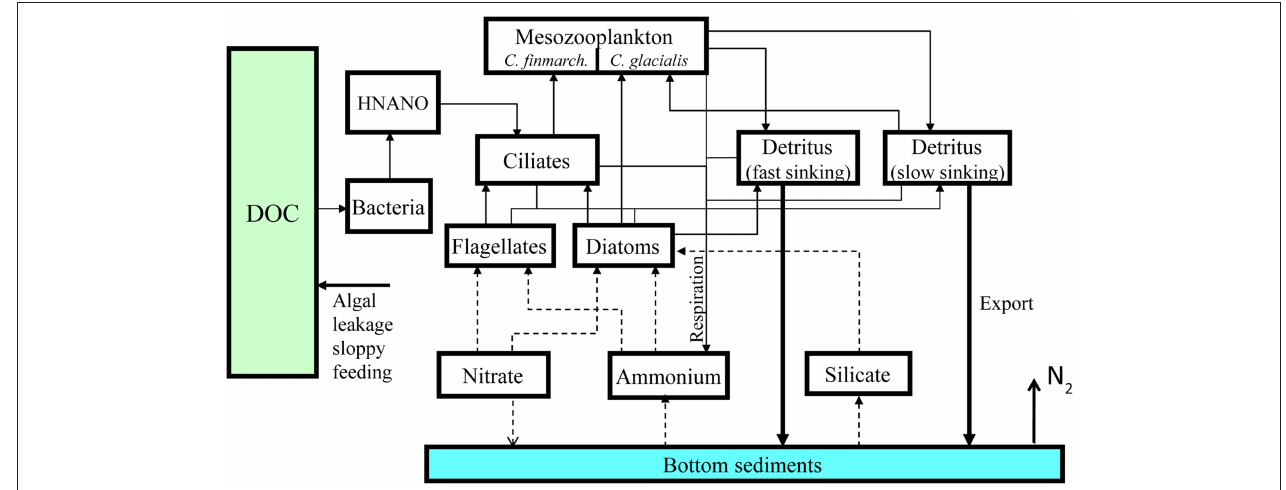
FIGURE 1 | Ecosystem model structure. See text for details and